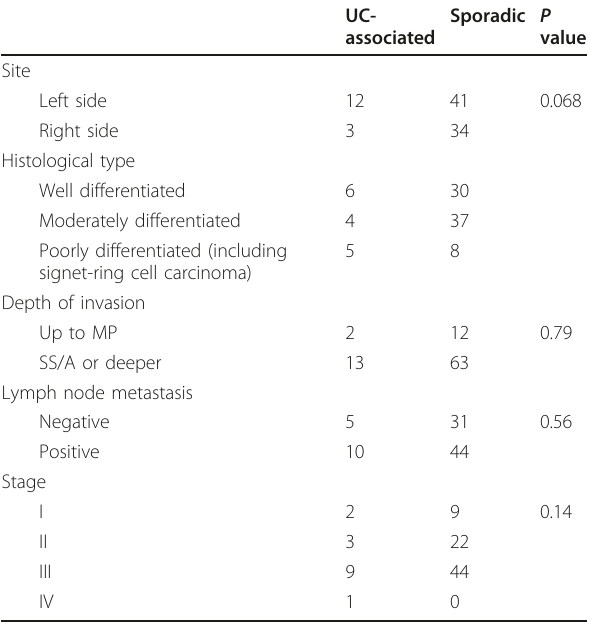
Table 2 Clinicopathological summary of the cases